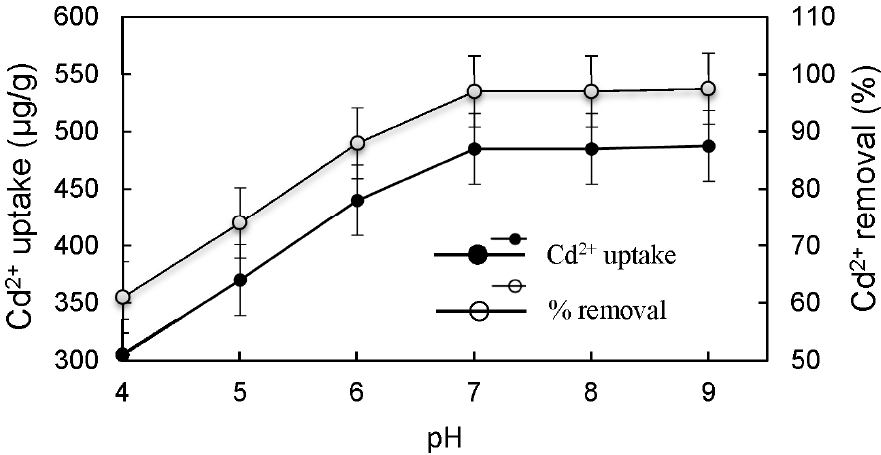
Figure 7. Effect of equilibrium solution pH on Cd 2+ uptake and removal.